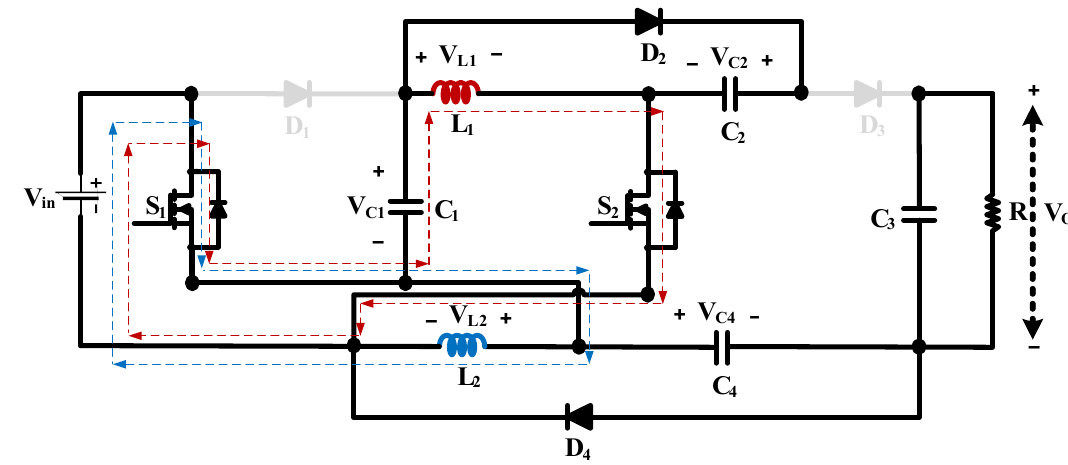
Figure 2. First mode of operation.